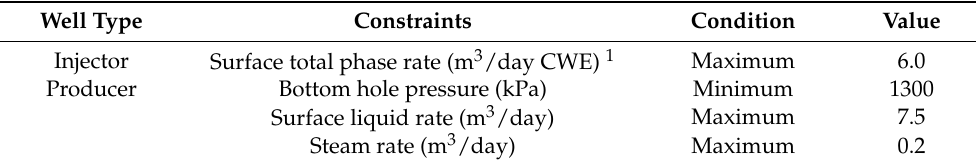
Table 3. Well constraints for the steam and gas push (SAGP) modeling.